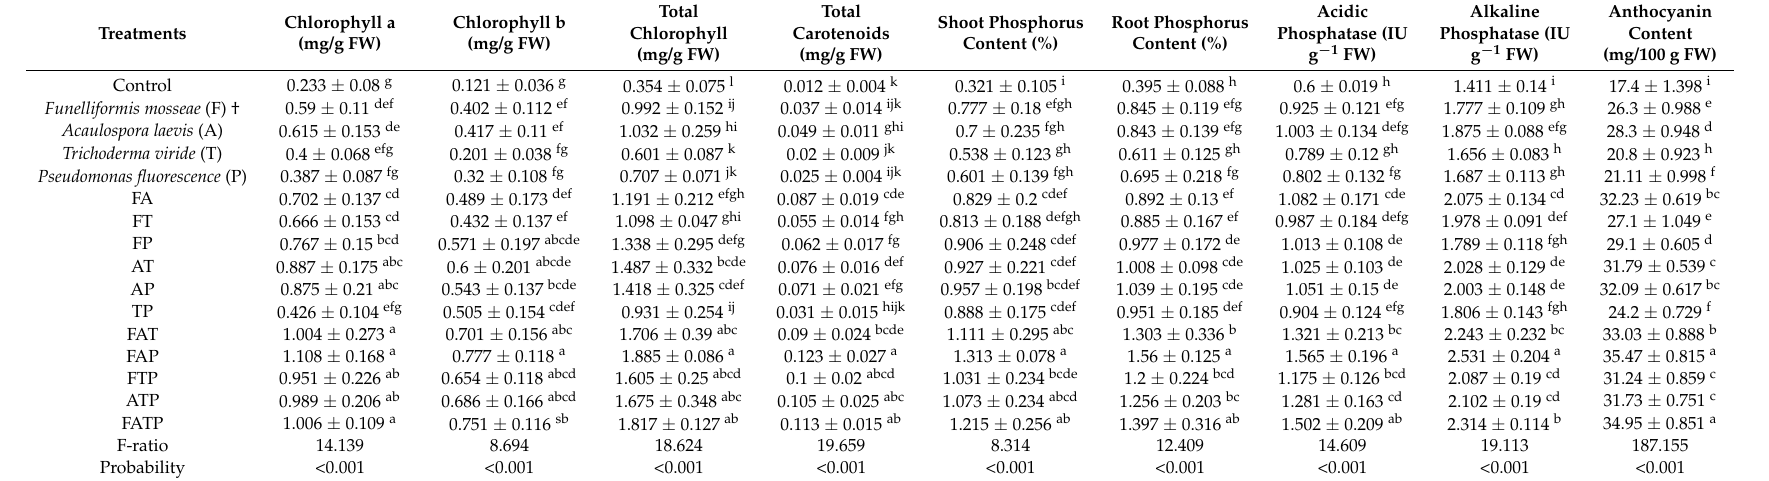
Table 4. Effect of bioinoculants on biochemical aspects of Gazania rigens